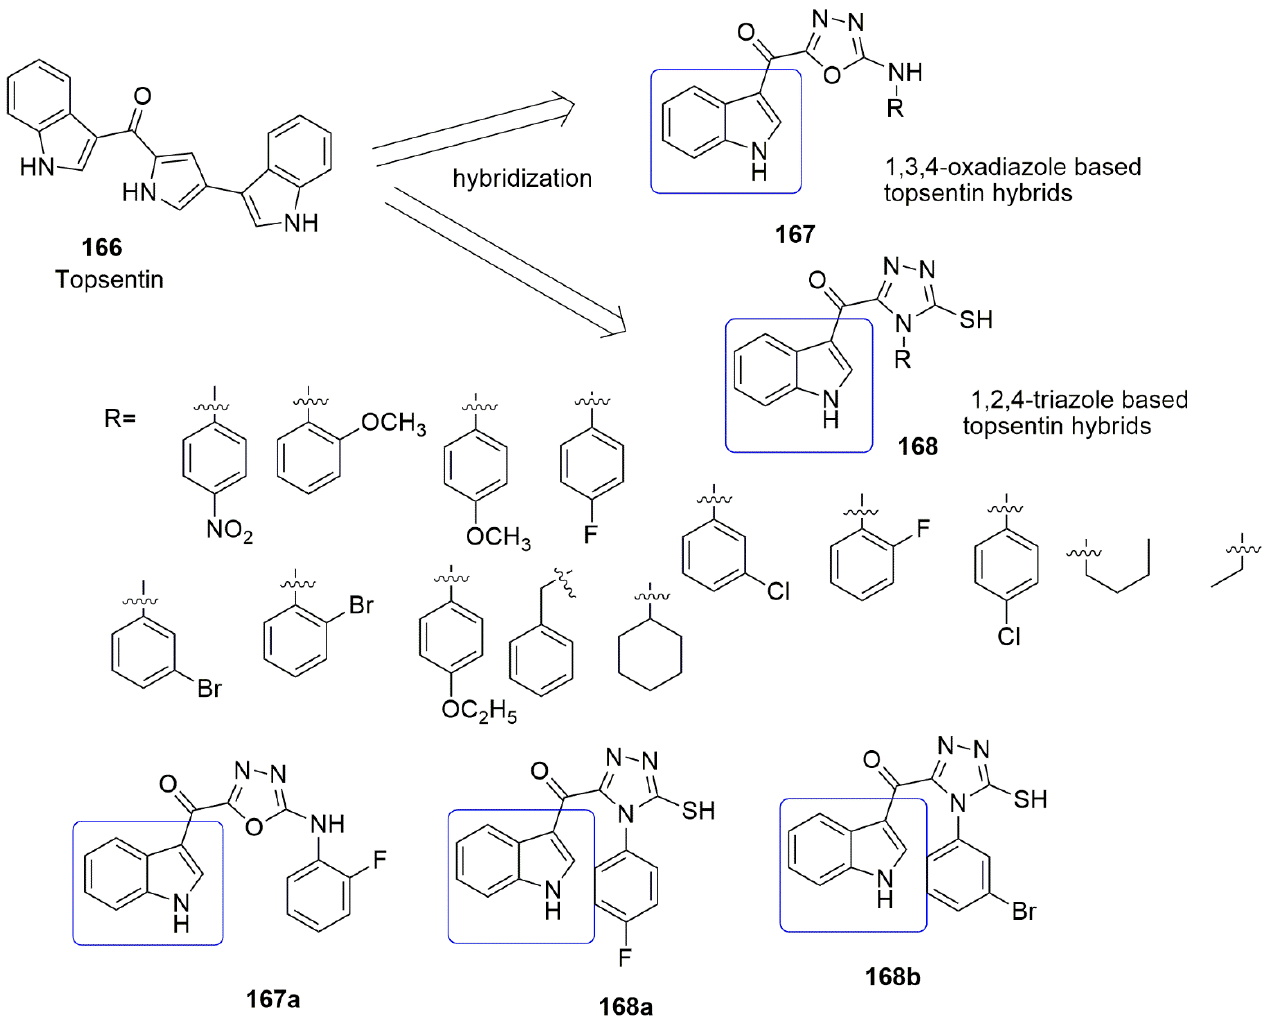
Figure 44. Chemical structure of indole-1,3,4-oxadiazole and indole-1,2,4-triazole-topsentin hybrids. Reports have shown the anti-tubulin potency of coscinamides ( 169 ), hyrtiosin B ( 171 ) which are natural containing compounds [139–141]. In addition, indibulin ( 170 ) bearing 1,2-diketo or α -keto amide functional group show strong anticancer activity [142]. Kumar et al. and Mukherjee et al. have demonstrated the anticancer activities of bis(indolyl)hydrazide-hydrazone ( 172 ) featuring hybrids [143,144]. Thus, compounds bearing pharmacophoric units such as α -ketoamide, diketone and hydrazide-hydrazone have therapeutic importance. Based on this panorama, Tantak and coworkers designed novel bis(indolyl)ketohydrazide-hydrazones by integrating α -ketoamide, diketone and hydrazide-hydrazone as potent tubulin inhibitors [145]. Twenty bis(indolyl)ketohydrazide-hydrazones conjugates were synthesized. They evaluated their anticancer activity against five-panel cancer cell lines by using ketohydrazid hydrazones as spacers for the two-indole ring in coscinamide moiety. The panel of cancer cell lines used in their studies includes human breast cell lines (BT474, MCF-7, and MDA-MB-231), human colon carcinoma cell lines (HCT-116), and leukemia cell line (Jurkat). The substitution of an indole ring in 173 with an aryl or pyridyl group resulted in compounds 174 with a percentage of cell survival more significant than 90% except for the Jurkat cancerous cell line. Compounds 173a – 173e displayed cytotoxic effects (<50% cell survival) against the cancer cell lines. 173d emerged as the most potent anti-proliferative agent against MCF-7, MDA-MB-231, HCT-116, and JURKAT cancer cell lines with IC 50 values of 0.8, 0.50, 0.15, and 0.22 µ M, respectively. SAR studies indicated that C-5 methoxy, Bromo, and N -(4-chlorobenzyl) groups were necessary for the superior anti-cancer